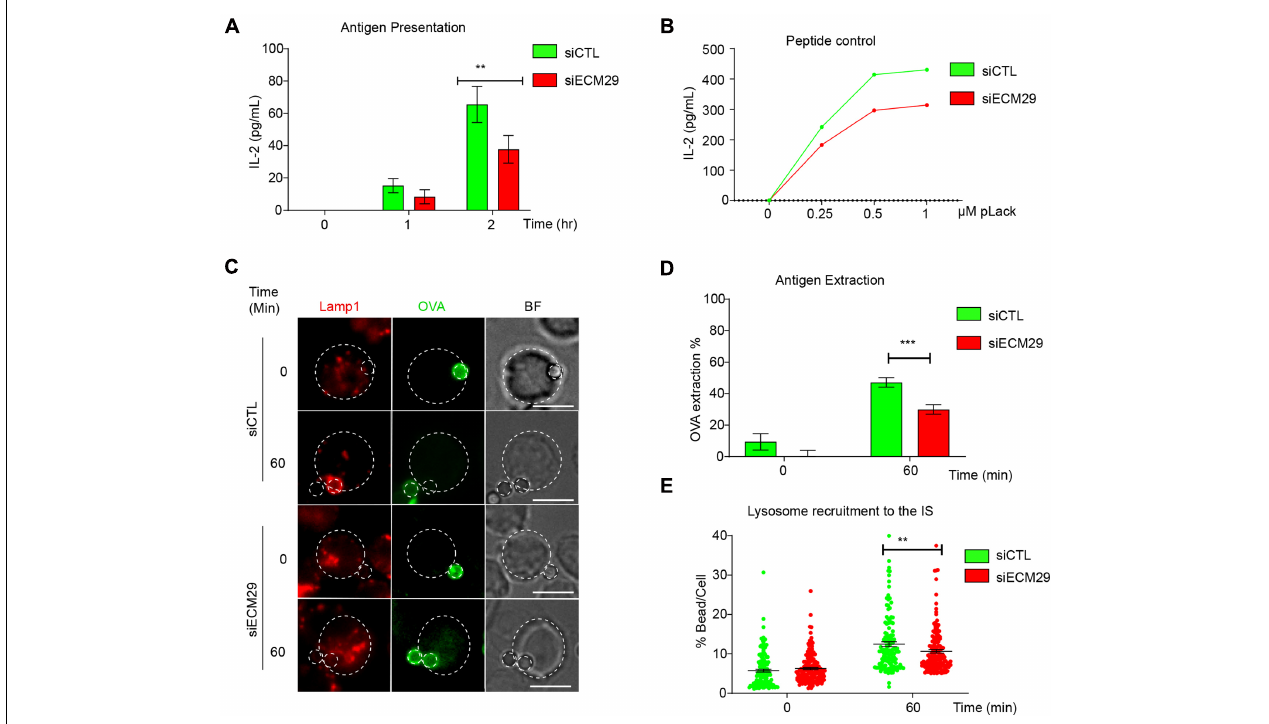
FIGURE 7 | Efficient antigen extraction and presentation requires Ecm29: (A) Antigen presentation assay for control (siCTL) and Ecm29 silenced (siECM9) B cells. Levels of IL-2 by T cells were quantified by ELISA. N = 3. (B) Representative graph of peptide controls for cells used in antigen presentation assays. (C) Representative images of control and Ecm29 silenced B cells activated with beads coated with anti-IgG + OVA in resting (0 min) and activating conditions (60 min). Lysosomes (Lamp1) and antigen (OVA) are shown. The white dashed circles delimit cell boundaries and bead. (D,E) Quantification of antigen extraction, measured as the amount of OVA extracted from the bead, and lysosome recruitment to the bead in (C) . N = 4. Cells > 82. ** p < 0.01. *** p < 0.001. Kruskal–Wallis test with Dunn’s test, and Mann–Whitney test was performed for all statistical analyses was performed for all statistical analyses. Mean with SEM bars (A,D) , individual cells (points) (E) are shown. Scale bar = 10 µ